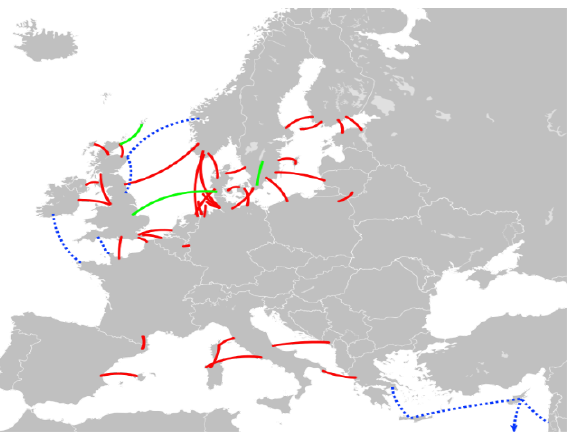
Figure 2. Existing, proposed, and under construction links between countries shown in red, blue, and green lines, respectively [2] .